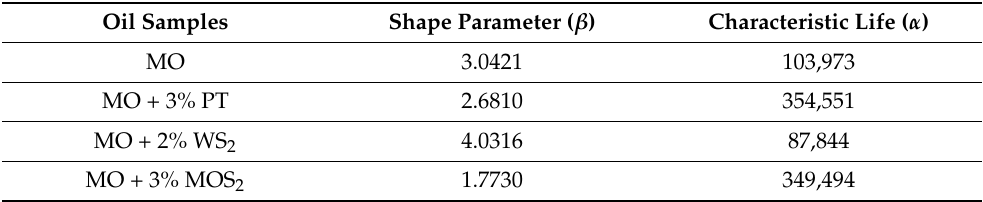
Table 3. Weibull parameters for the oil